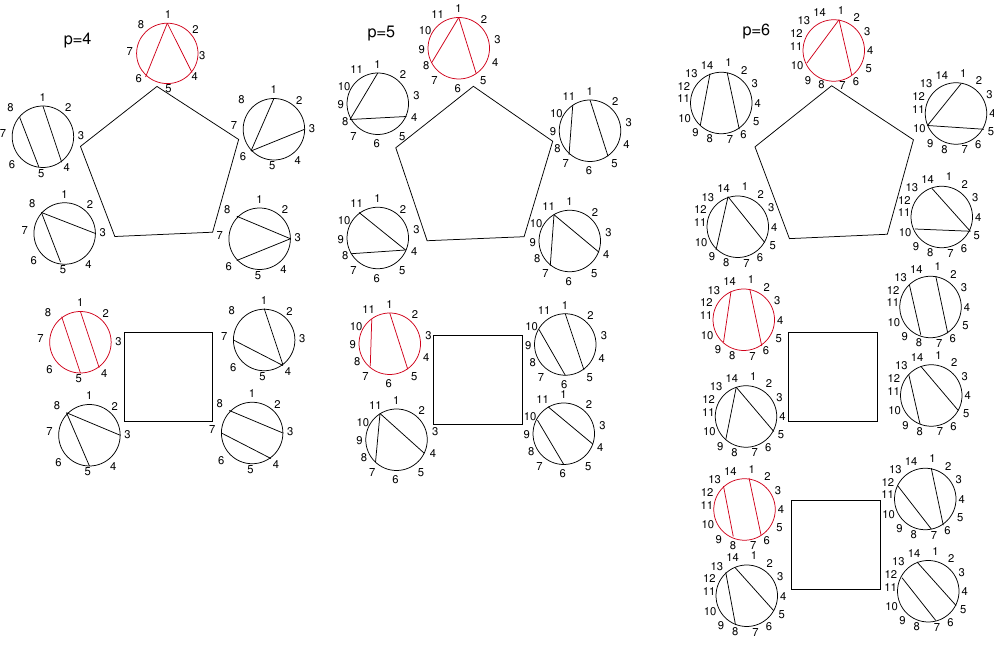
Figure 2 . Accordiohedra for the n = 2 case. The red circles indicate the reference p